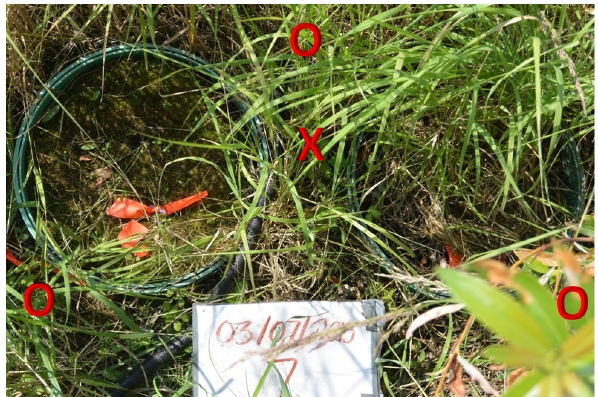
Figure 2. Example of a plot with a collar pair in the wetland area il- lustrating a collar excluding vegetation (on the left) and a vegetated collar (right) and surface PRS probes (orange and purple tabs with orange flagging tape; locations outside the collar are marked with circles). The permanent soil thermocouple profile post is marked by an “X”. This plot is from the lowland unsaturated category (bottom of the easternmost boardwalk, Fig. 1), and the photograph was taken on 3 July